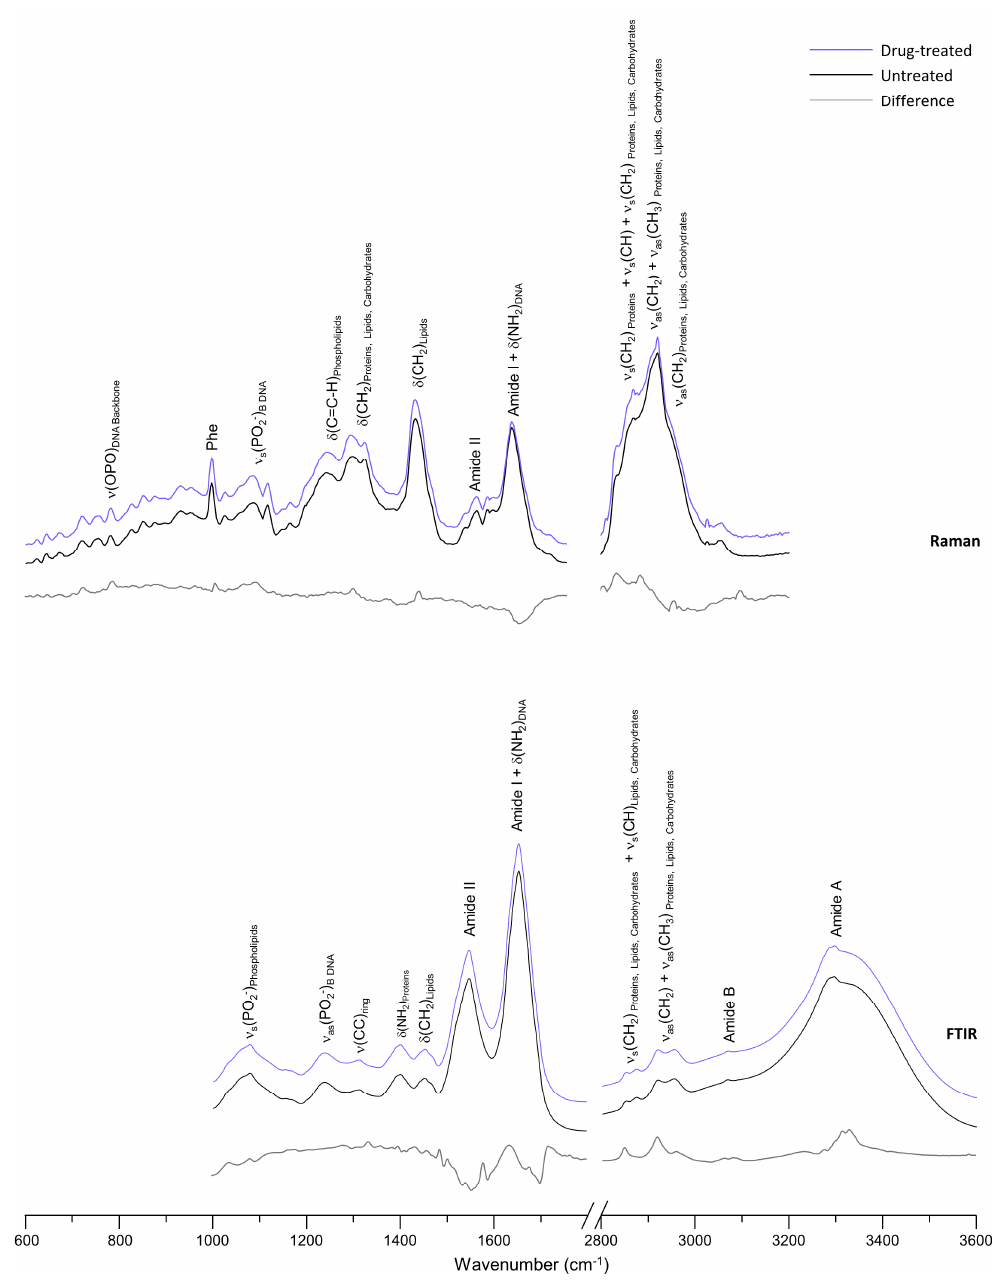
Figure 4. Mean Raman (600–3200 cm − 1 ) and FTIR (1000–3600 cm − 1 ) spectra for untreated (control) and [Pt 2 Put 2 (NH 3 ) 4 ] 4+ -treated A549 cells. The respective difference spectra to the control (drug- treated minus untreated) are also plotted.